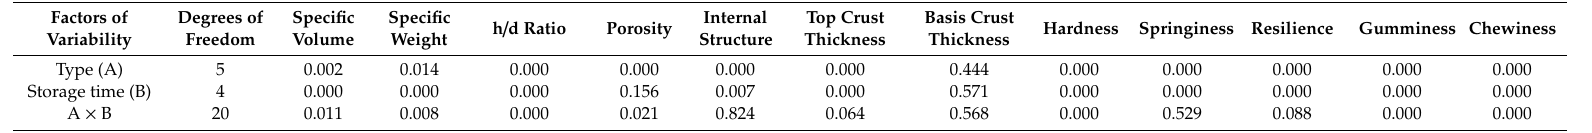
Table 4. Analysis of variance of the physical and textural parameters studied on the loaves ( p -values).